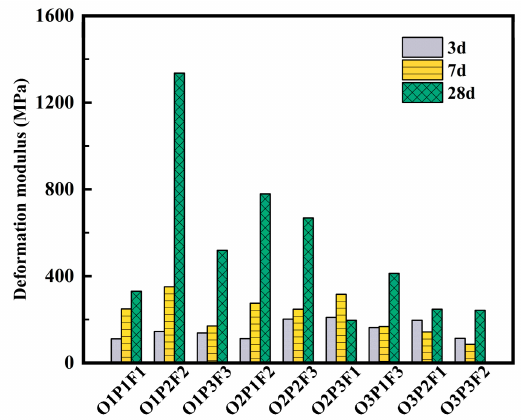
Figure 7. Deformation modulus of solidified soil